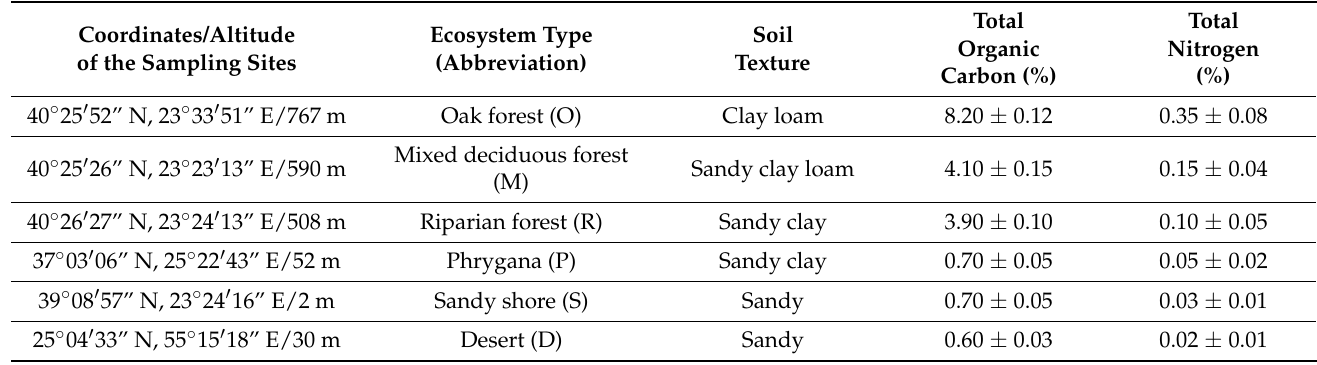
Table 1. Soil texture, organic matter, and organic nitrogen content (average ± se) of soil samples from the six ecosystem types that were used in the experiments, and coordinates and altitude of the sampling